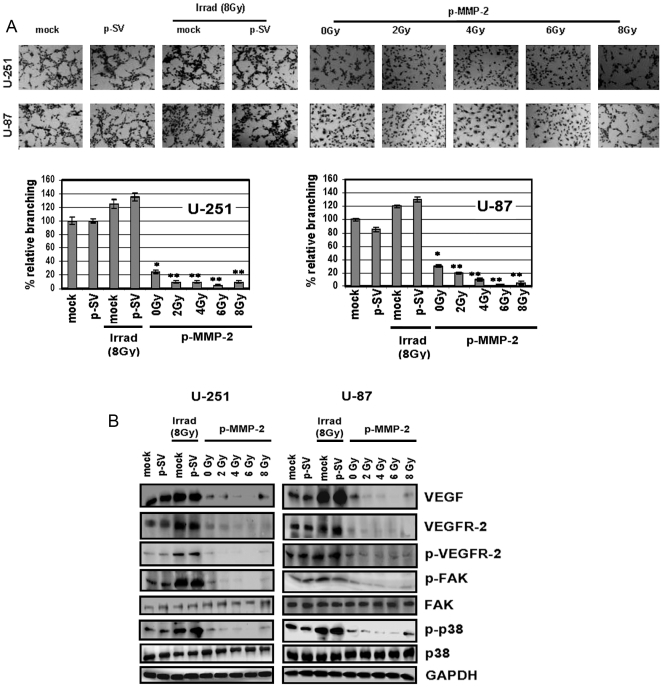
p-MMP-2 inhibits radiation-enhanced tumor culture medium-induced microtubule network formation in endothelial cells and downregulates expression of angiogenesis-associated molecules.
A, Human microvascular endothelial cells (5×104) were seeded in 96-well plates and cultured with conditioned medium collected from U-251 and U-87 glioma cells transfected with mock, p-SV, and p-MMP-2, and irradiated as described earlier. 24 h after radiation treatment, the cells were washed, fixed and stained with Hema-3 and photographed. Percentages of branches were quantified by counting five fields in each condition. Columns: mean of triplicate experiments; bars: SD; *p<0.01, **p<0.001, significant difference from mock or irradiated controls. B, U-251 and U-87 transfection and radiation was carried out as described earlier. 24 h after radiation, whole cell lysates were prepared and analyzed by Western blotting for the angiogenic molecules VEGF, VEGFR-2 and p-VEGFR-2 as well as p-FAK, FAK, p-p38 and p38. GAPDH served as a loading control.